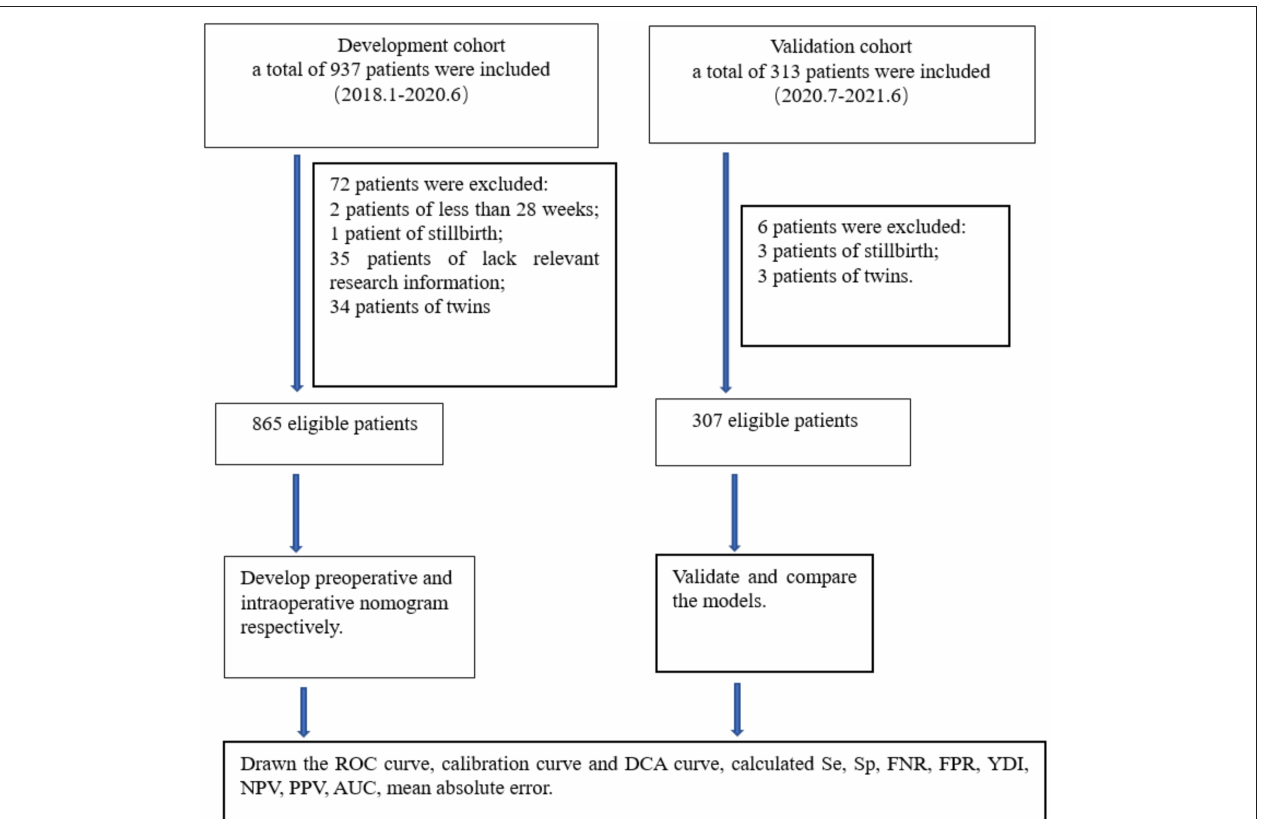
FIGURE 1 | Flow chart for study design. ROC, receiver operating characteristic; DCA, decision curve analysis; Se, sensitivity; Sp, specificity; FNR, false negative rate; FPR, false positive rate; PPV, positive predictive value; NPV, negative predictive value; AUC, area under the receiver operating characteristic curve; YDI, Youden’s index.